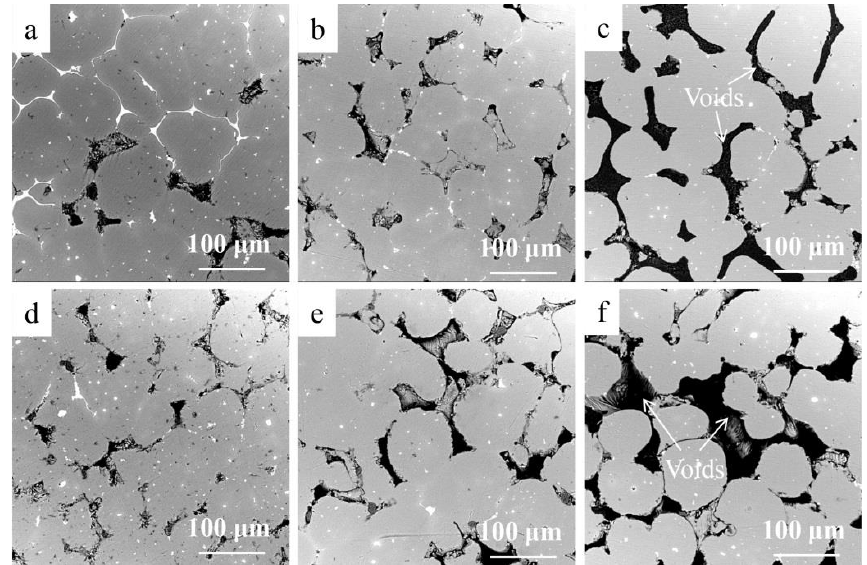
Figure 11. Morphology of layer 3 (( a ): 400 G ; ( b ): 700 G ; ( c ): 1000 G ) and layer 4 (( d ): 400 G ; ( e ): 700 G ; ( f ): 1000 G ) in the residual part (609 °C).